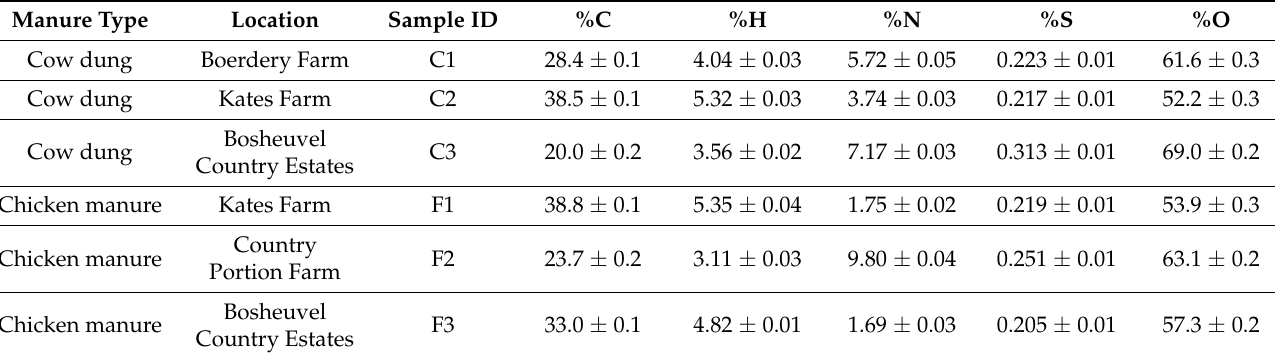
Table A2. Elemental composition of animal